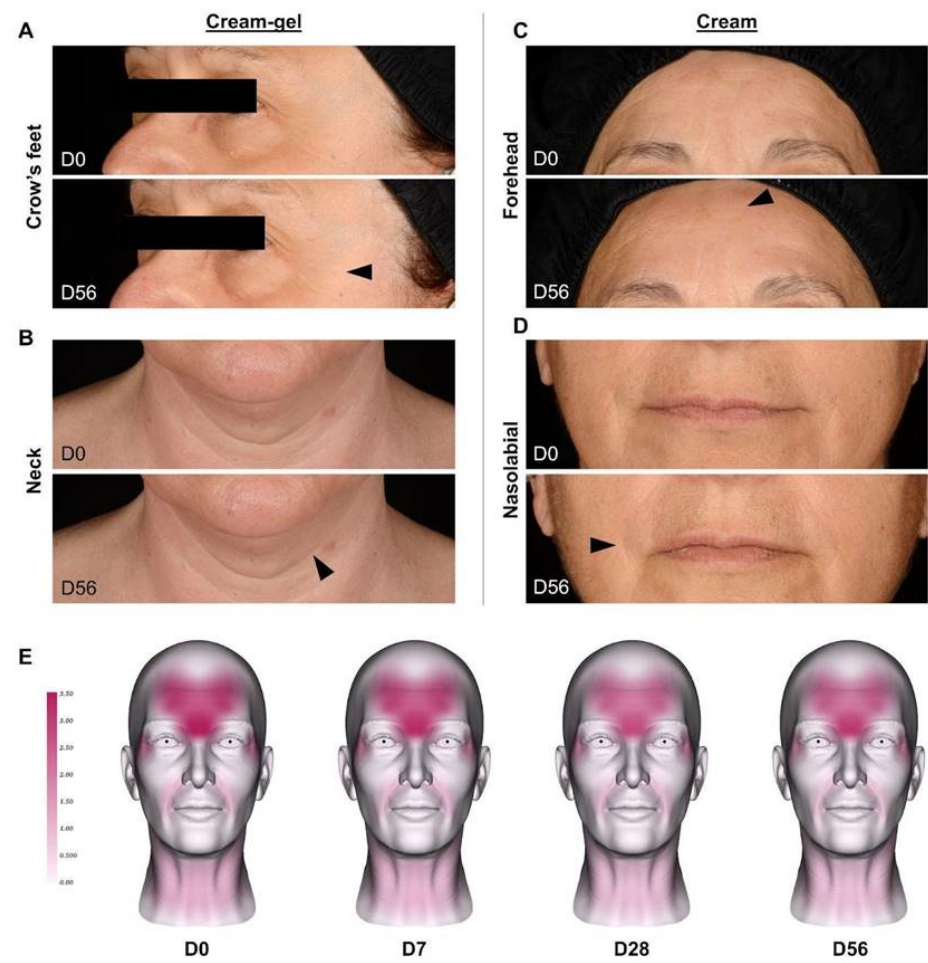
Figure 2. Evolution of the wrinkles at D0 (baseline) and D56 on the crow’s feet ( A ), neck ( B ), forehead ( C ) and nasolabial ( D ) regions of representative subjects. The black arrow indicates the clinical improvement of the wrinkle. ( E ) Time course of wrinkle reduction modeled by continuous 3D color density imaging, representative of the mean surface parameter of the cream-gel study ( n = 30 subjects).